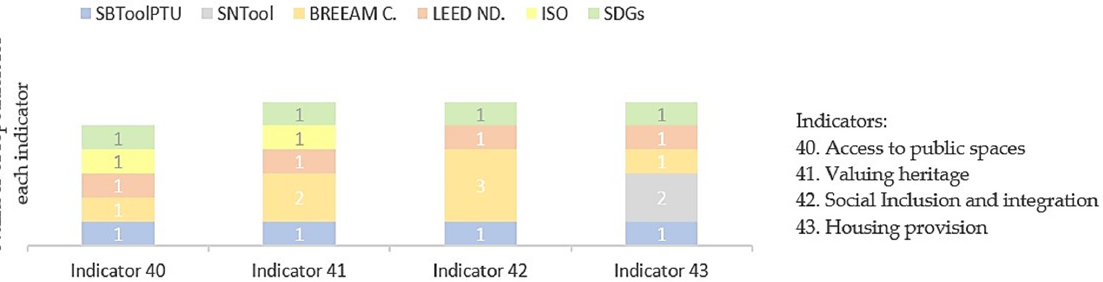
Figure 11. Frequency distribution of each indicator, relevant to the category of local and cultural identity in SBTool PT _Urban (2018), SNTool Min (2020), BREEAM-C (2012), LEED-ND (2018), ISO 37120, and SDGs.